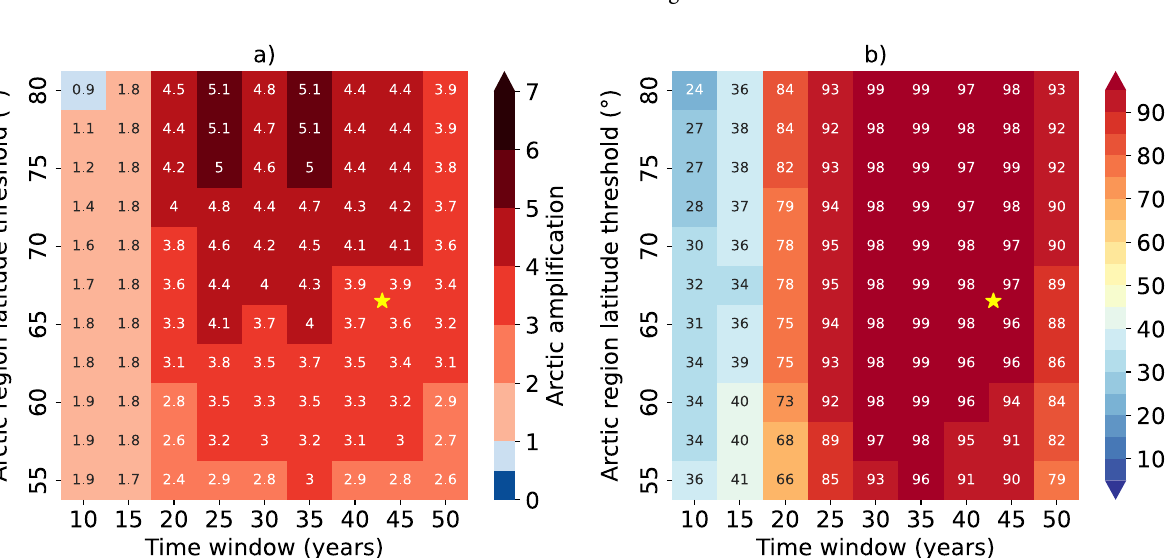
Fig. 2 The sensitivity of Arctic ampli fi cation ratio to the Arctic area and the period of interest. The sensitivity of Arctic ampli fi cation (AA) ( a ) to the time window used in calculating the linear trends (x-axis) and the southern boundary of the Arctic (y-axis), and ( b ) the percentile rank of the observed AA in the CMIP6 ensemble distribution. The end year of all linear trends is fi xed to 2021. Thus, for example, 50 years on the x-axis corresponds to the trend calculated for 1972 – 2021. The star marks the baseline value used in the study, corresponding to the 43-year linear trend and the southern boundary of 66.5 ∘ N. The observed AA is derived from the average of the four observational